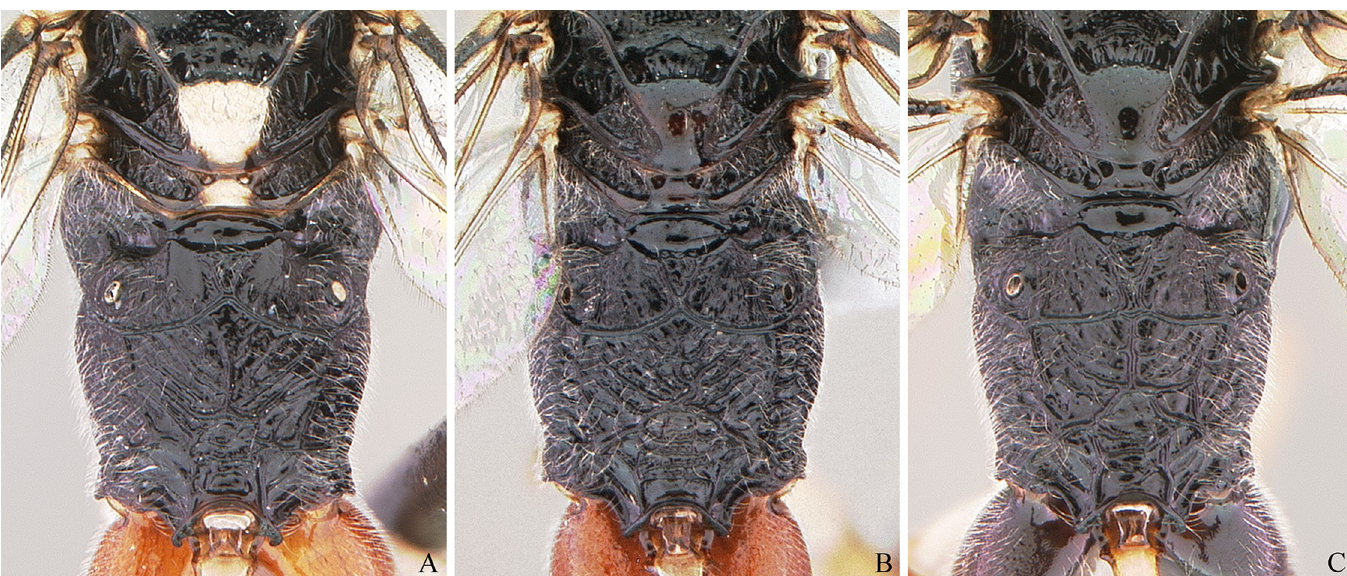
Fig 20. Males of Cryptoxenodon metamorphus sp. nov. from the paratype series. Propodeum, dorsal view. (A) FAS4620, Alt. 16m, Brazil/PA. (B) UFES49766, Alt. 150m, Brazil/BA. (C) UFES47242, Alt. 650m,